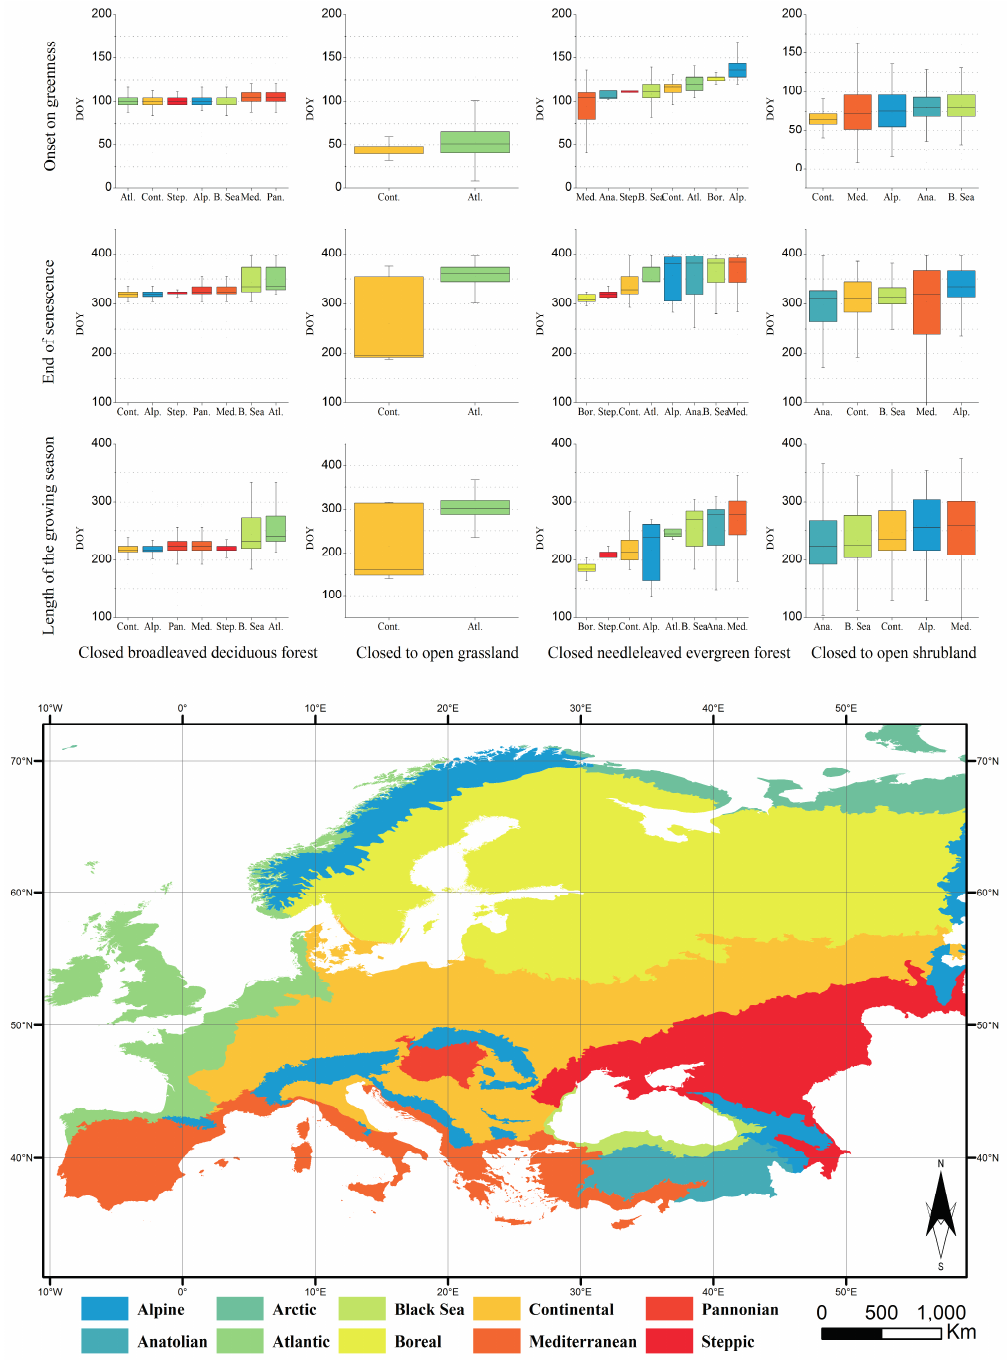
Figure 4. Boxplots showing the distribution of OG, EOS, and LS for each vegetation type and biogeographical region (box, interquartile range; horizontal line, median; vertical lines, minimum and maximum). Box plots are shown ordinally from earliest to latest date and resume the information about the timing of phenophases from 2003 to 2011. Map shows the spatial distribution of the European biogeographical regions delineated in the Habitats Directive (92/43/EEC). Colours in the map correspond to the colours of boxplots. Alpine (Alp), Anatolian (Ana), Black Sea (B. Sea), Continental (Cont), Mediterranean (Med), Panonian (Pan), and Steppic